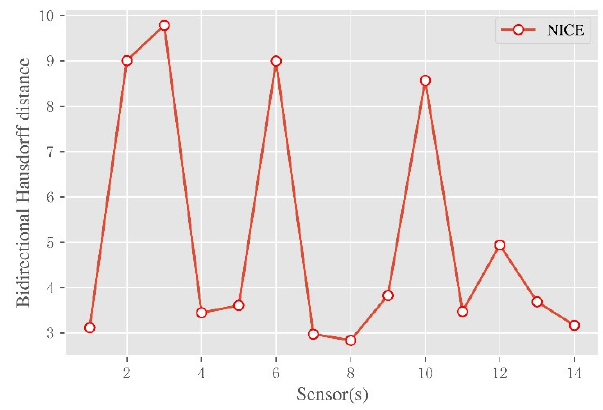
Figure 8. The generated results of the NICE model.